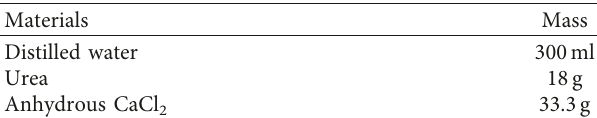
Table 2: Mass of each component in cementation solution of 300mL.